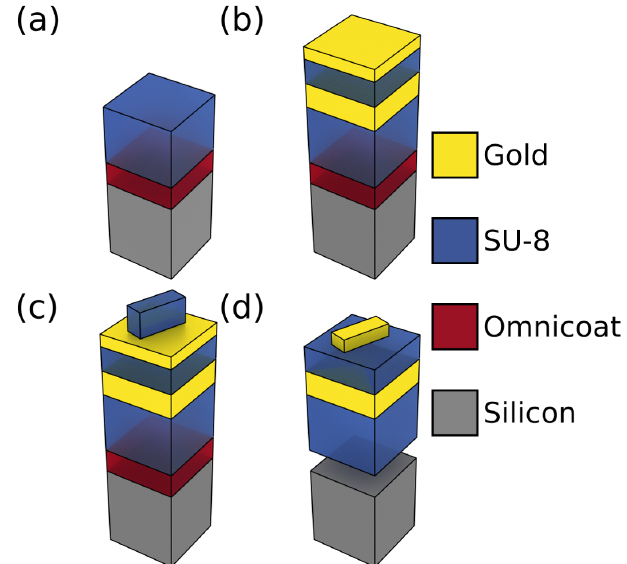
Figure 5. The fabrication steps for our MS. ( a ) Spinning a lift-off layer and a thick SU-8 manipulation layer; ( b ) evaporation of two layers of gold spaced by an SU-8 layer; ( c ) spinning, electron beam exposure, and development of an SU-8 resist layer; ( d ) dry etching to remove unmasked gold and dissolving the Omnicoat